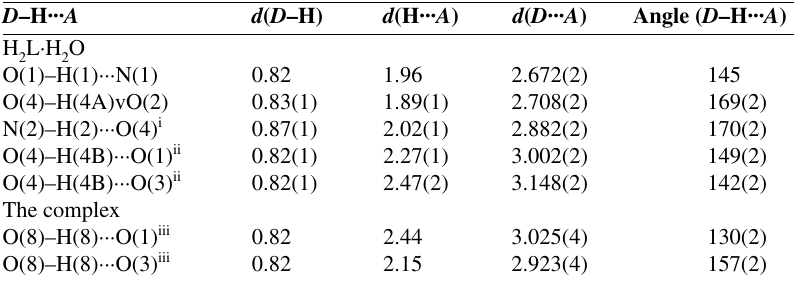
L · H O and the 2 2